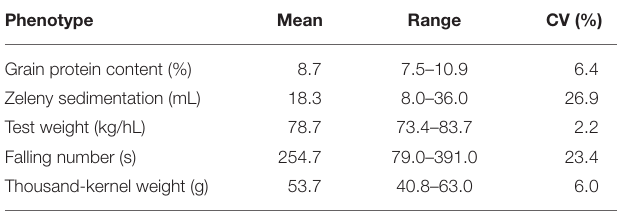
TABLE 3 | Mean, range, and coefficient of variation (CV) for phenotypic